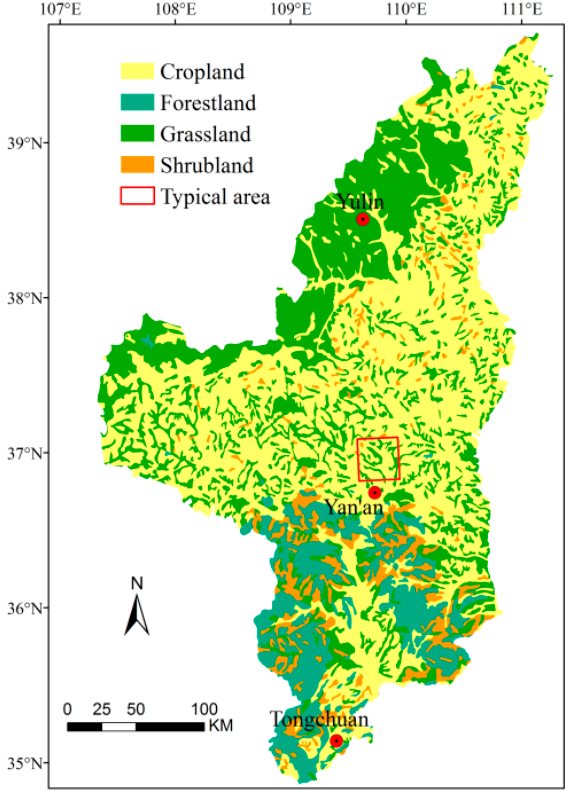
Figure 2. Spatial distributions of major land use types in Northern Shaanxi for 2000.